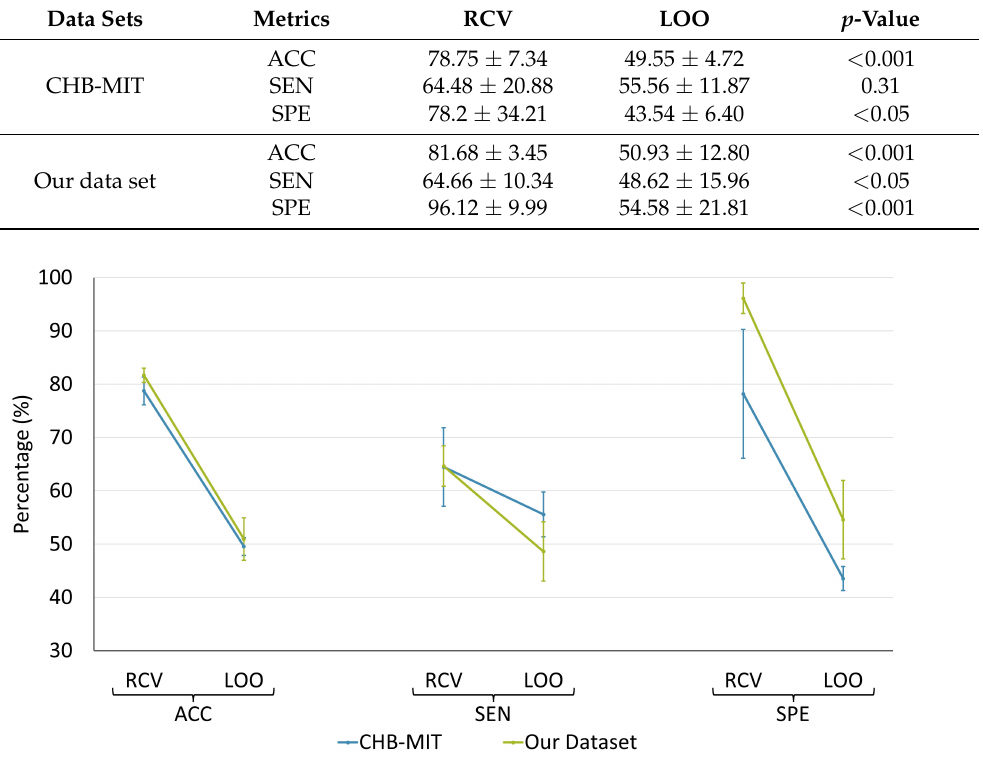
Figure 5. Comparison of the average performance metrics for classifying interictal and preictal phases on the CHB-MIT data set and our data set using RCV or LOO validation methods. Error bars represent the standard error of the